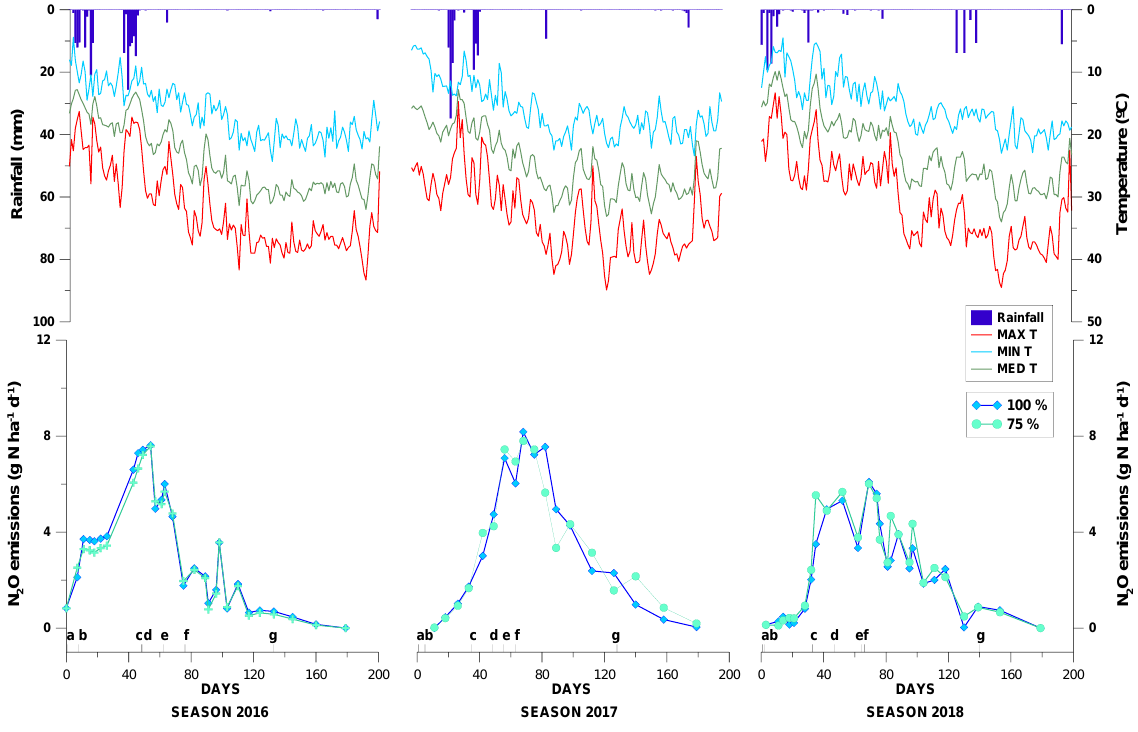
Figure 4. Daily emission of N 2 O according to the applied irrigation dose. The different letters indicate: a = seeding; b = first fertilisation with DMPP; c = first fertilisation with U and AN; d = second fertilisation with DMPP; e = second fertilisation with U and AN; f = first irrigation; g = last irrigation.